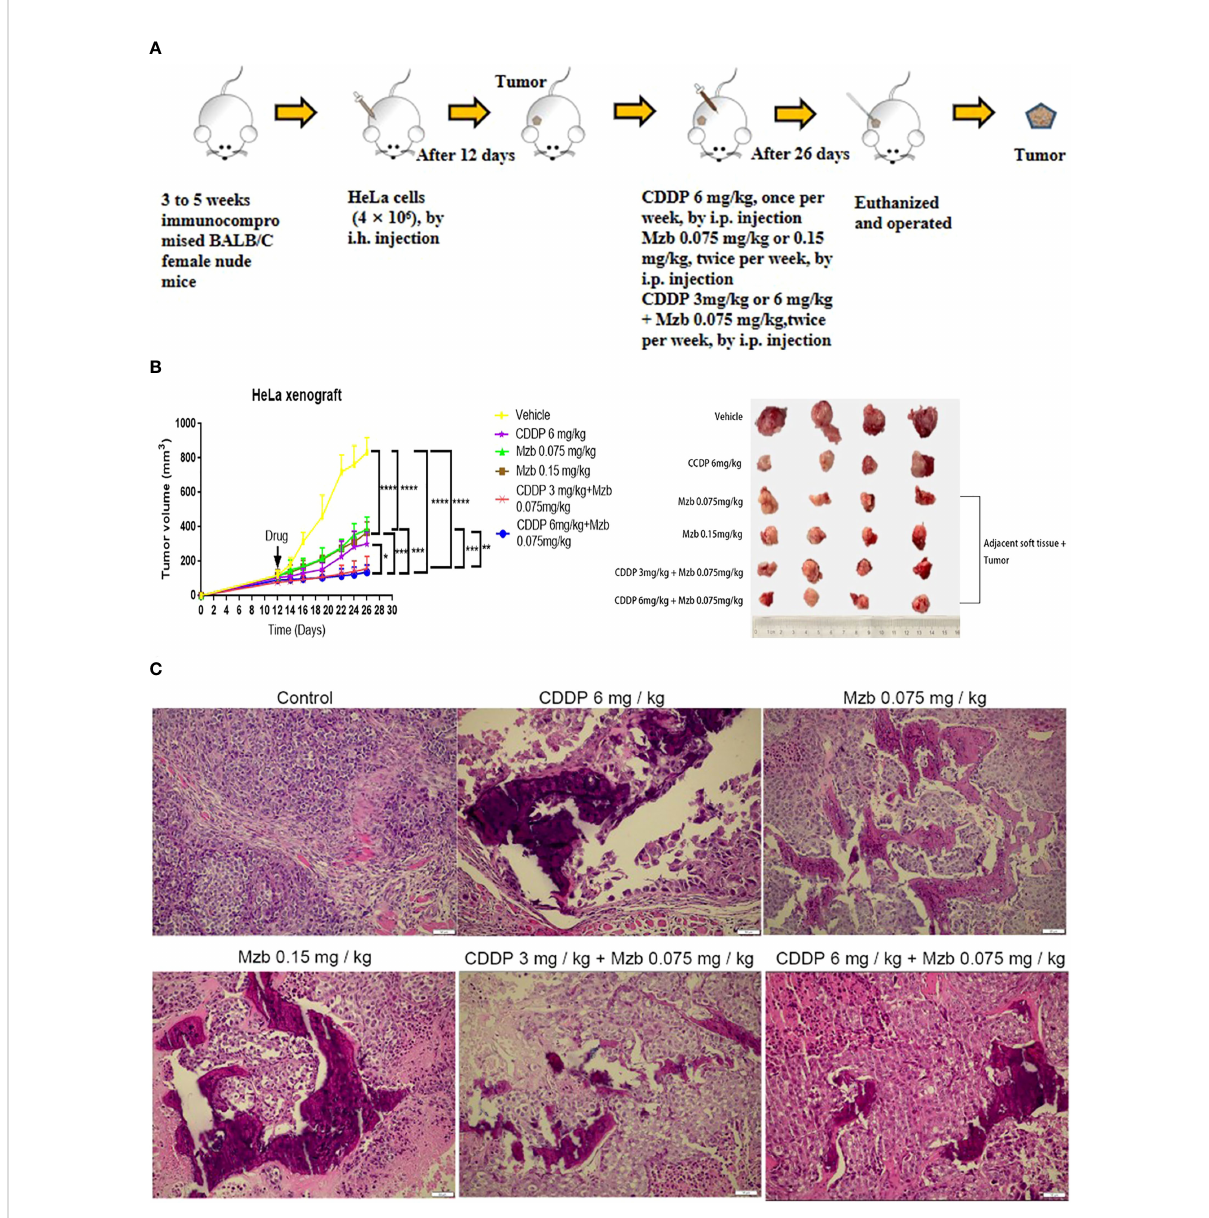
FIGURE 6 Marizomib boosts the inhibitory effect of CDDP on the growth and invasion of cervical cancer xenografts in vivo. (A) Schematic of the subcutaneous injection of HeLa cells into the right axilla offemale nude mice and drug intervention after tumorigenesis. (B) Xenografts were treated with CDDP alone (6 mg/kg), marizomib alone (0.075, 0.15 mg/kg) or a combination of two drugs (CDDP 3 mg/kg and marizomib 0.075 mg/kg, CDDP 6 mg/kg and marizomib 0.075 mg/kg) for 2 weeks, and changes in tumor volume were measured and plotted. *P < 0.05, **P ≤ 0.01, ***P ≤ 0.001, ****P ≤ 0.0001, by ANOVA (Dunnett ’ s multiple comparison post-test). (C) Growth and invasion in the xenografts in each group were observed by H&E